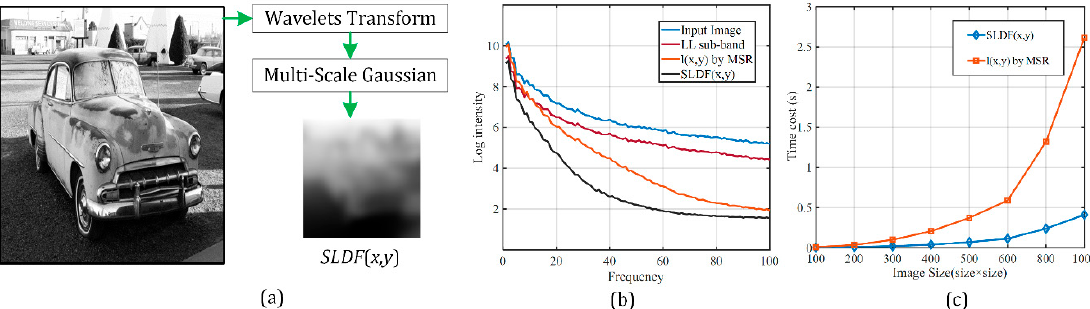
Figure 3. ( a ) Illuminance feature SLDF ( x , y ) extraction. ( b ) Frequency domain analysis. ( c ) Time-consumption of SLDF ( x , y ) and MSR.